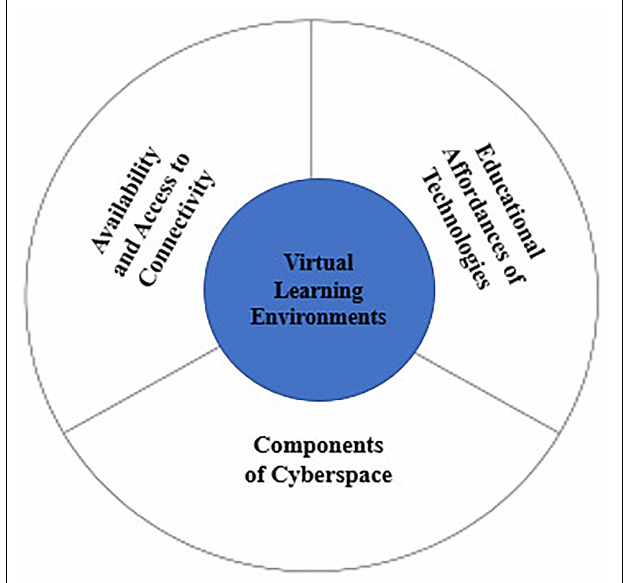
FIGURE 1 | Integrated taxonomy for virtual learning